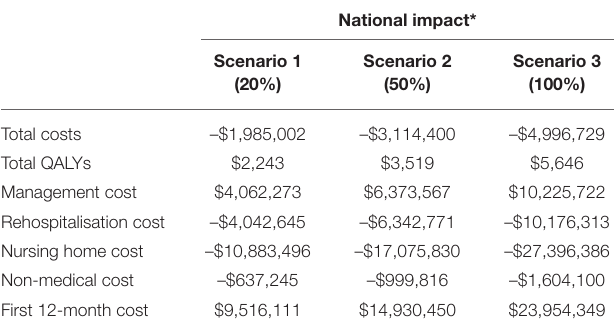
TABLE 3 | Results from the national